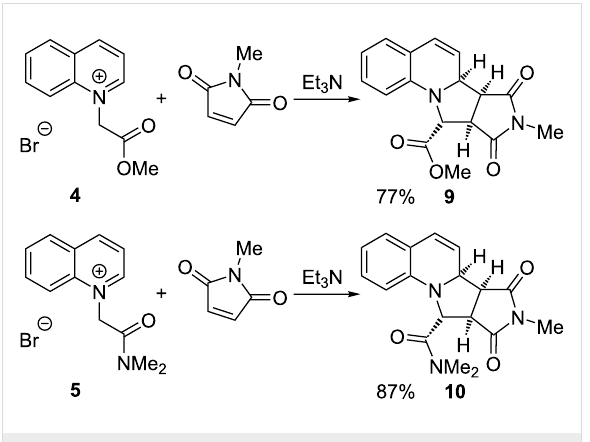
stereochemistry of the adduct 9 was determined by single crystal X-ray analysis (Figure